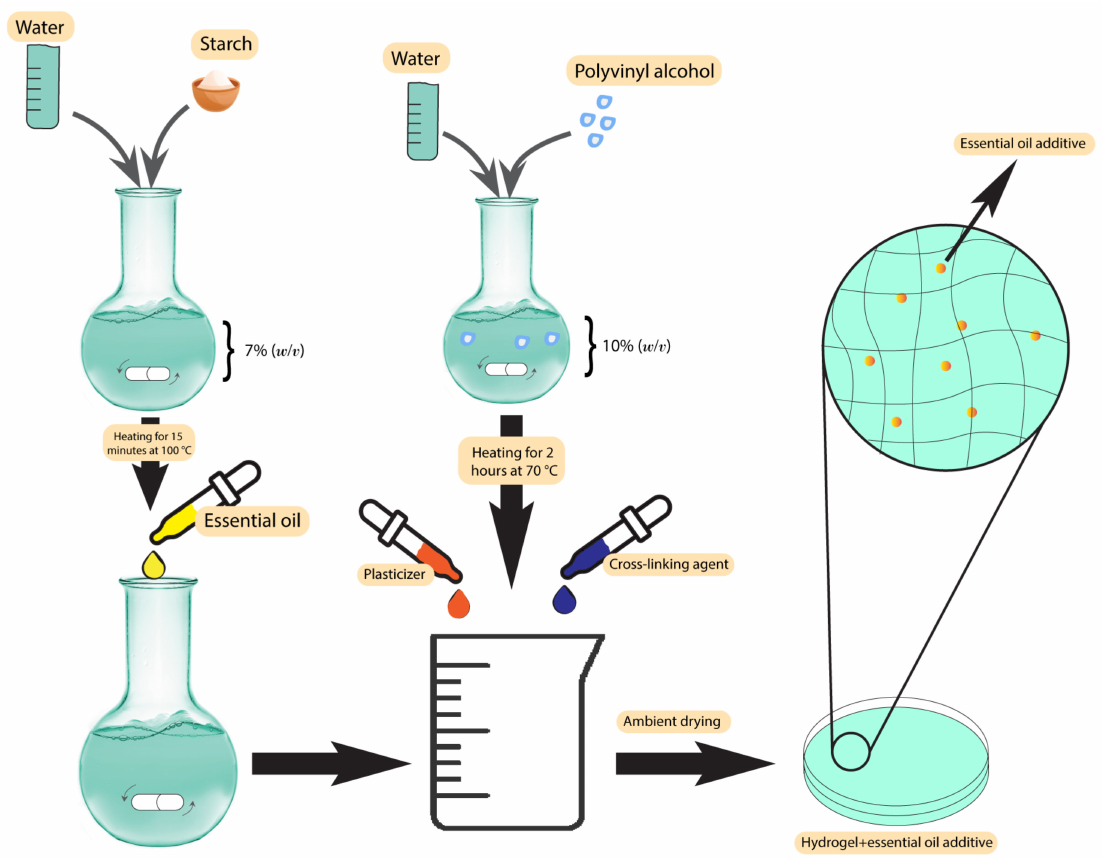
Figure 2. Synthesis scheme of polyvinyl alcohol/starch hydrogel